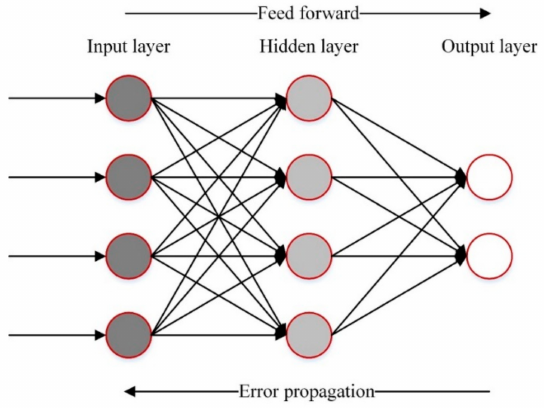
Figure 3. Typical three-layer neural